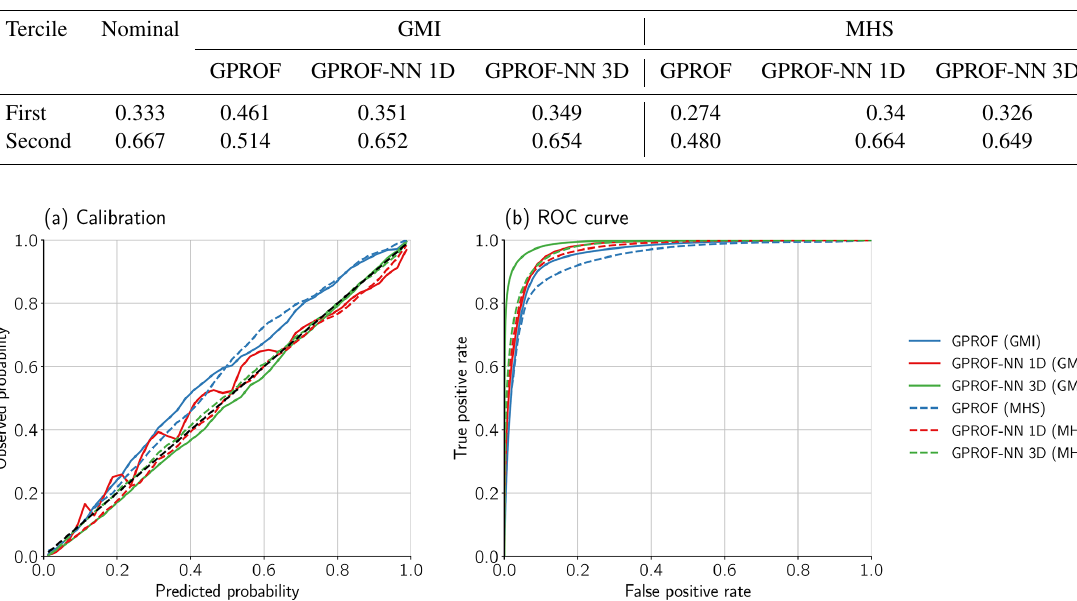
Table 6. Calibration of the predicted terciles of the posterior distribution of surface precipitation for the three retrieval algorithms and the GMI and MHS sensors.